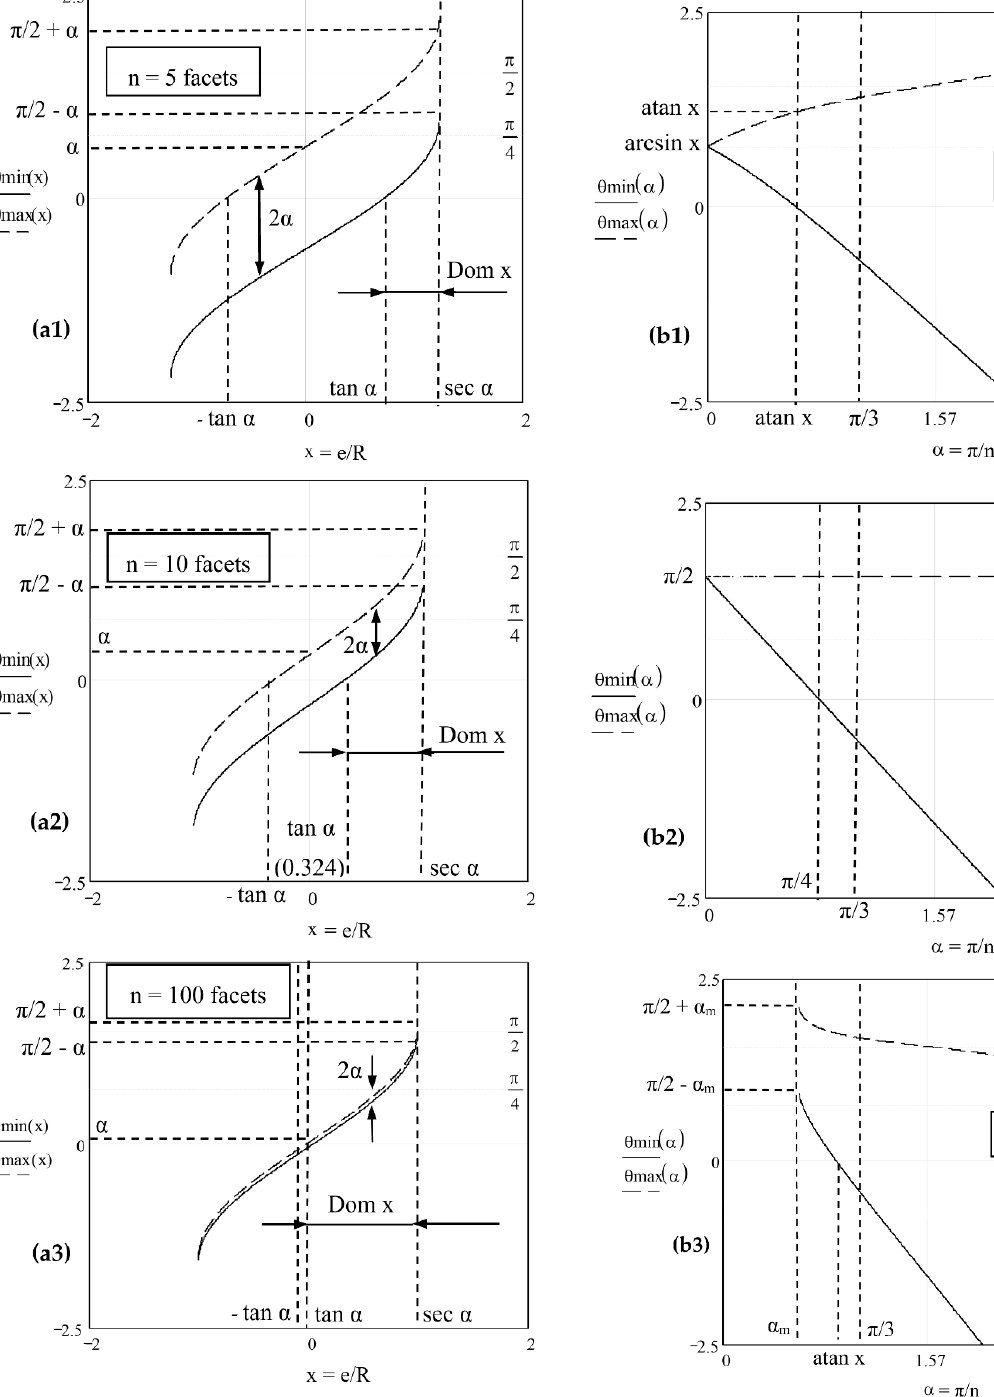
Figure 6. Study of the extreme scan angles of the PM, θ min and θ max (for which the ray reaches the margins of a PM facet) with regard to ( a1 – a3 ) the angle α = π / n ) and ( b1 – b3 ) the unitless parameter x = e / R for different intervals of each of the two